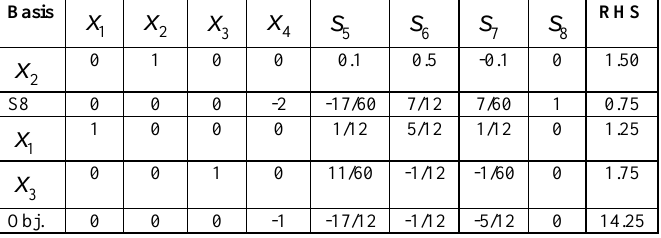
Table 2. Final table of the simplex